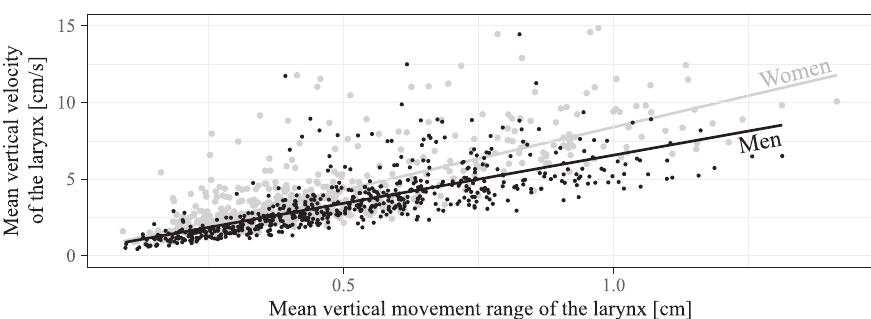
Fig 4. Sex-dependent linear relationship between the mean vertical movement range of the larynx and the mean vertical velocity of the larynx. Each point represents the value pair for one specific combination of subject, vowel pair, and speaking rate. The linear relationships that were found for the women ( ρ = 0.778, p < 0.001) and for the men ( ρ = 0.591, p < 0.001) are displayed in terms of the regression lines. For visualization purposes, five points per sex in the range from 15 cm/s to 30 cm/s are not displayed here. The intercept and the slope of the regression lines were 0.13 cm/ s and 6.85 Hz, respectively, for men, and -0.04 cm/s and 8.82 Hz, respectively, for women.